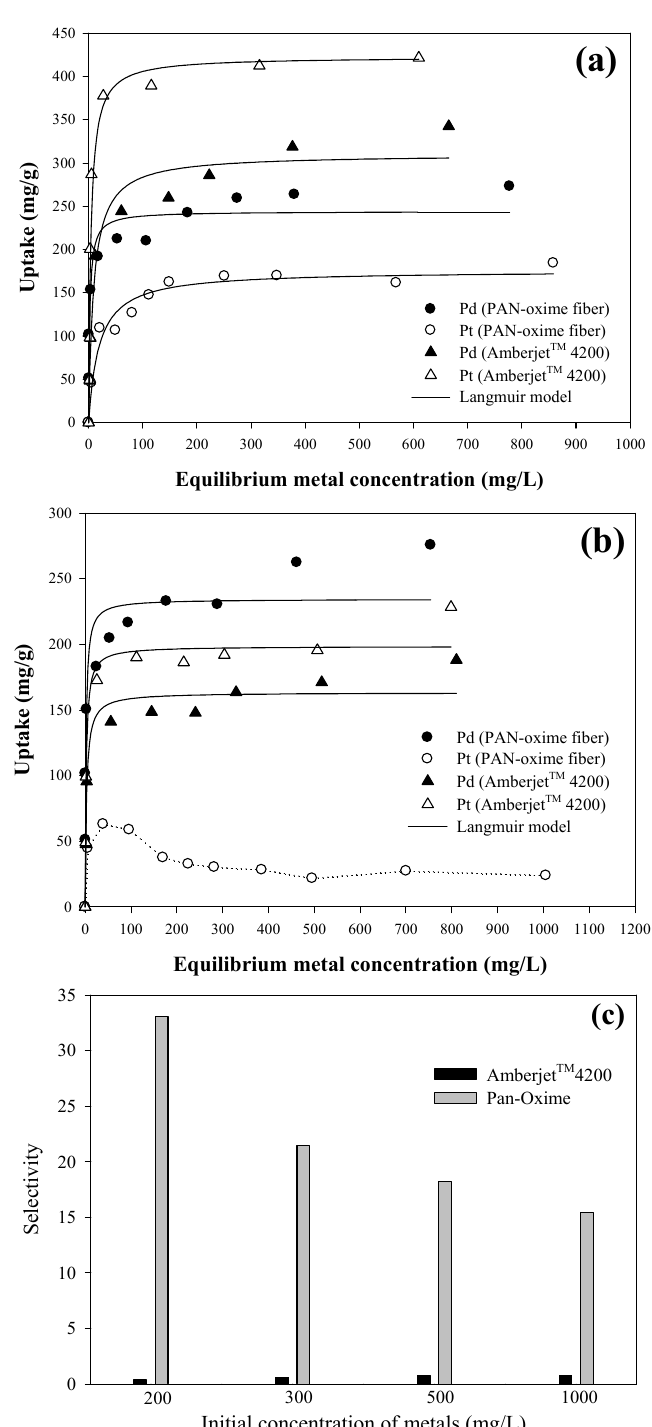
Figure 5. Adsorption isotherms of PAN–oxime fiber and Amberjet™ 4200. ( a ) Single-metal system; ( b ) binary metal system; and ( c ) selectivity. Standard errors are less than 5%.